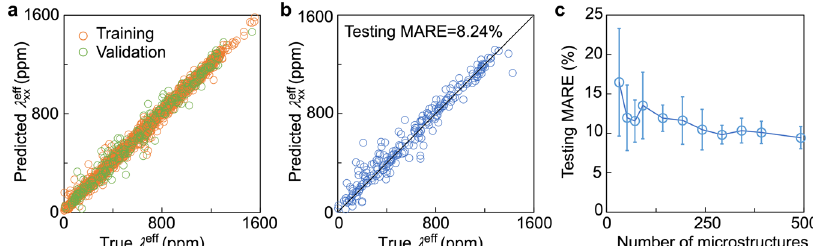
Fig. 4 Property prediction by the trained GNN model. a Predicted effective magnetostriction λ eff vs. ground truth of the independent testing dataset. The GNN model used in ( a ) and ( b ) are trained, validated, and datasets. b Predicted λ eff xx tested based on a dataset of 492 microstructures (2287 data points). c Macro average relative error (MARE) of the GNN models trained using datasets of different sizes. A lower MARE value indicates better prediction performance. The error bar indicates the standard deviation of the MARE.